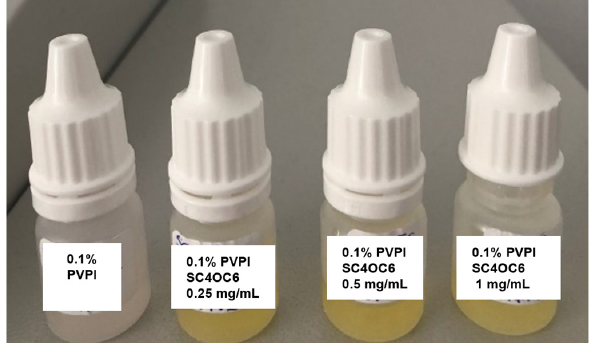
Figure 8. Samples of 0.1% PVPI solution alone (far left) and with different amounts of SC4OC6, after 3 months in plastic dropper containers at 4 °C.